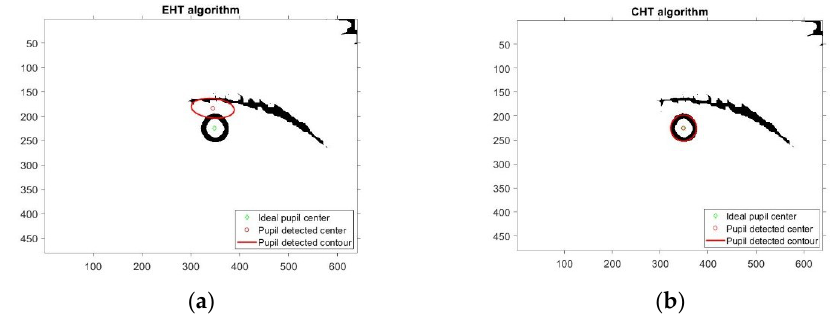
Figure 10. Results provided by EHT and CHT algorithms on the same noisy eye image and circular shape of the pupil: ( a ) failed detection for the EHT algorithm; ( b ) accurate detection for the CHT algorithm.